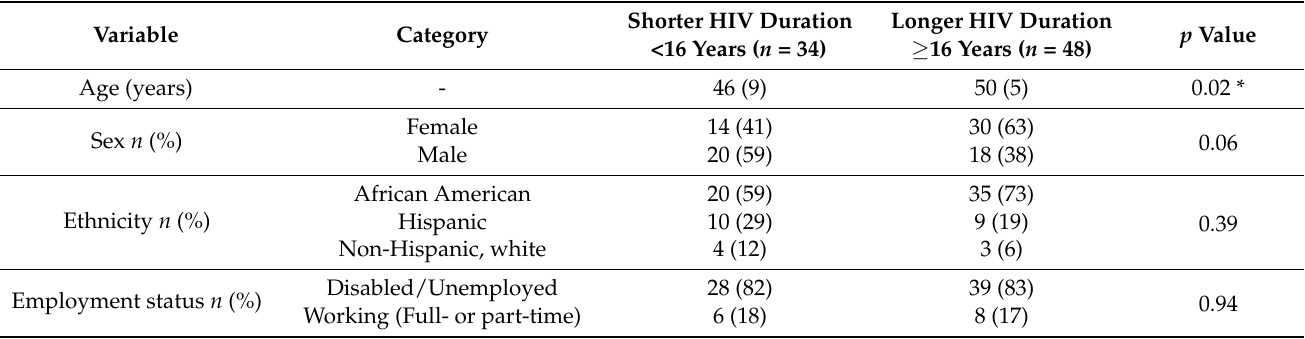
Table 1. Demographic, Physical and Lifestyle Characteristics of Study